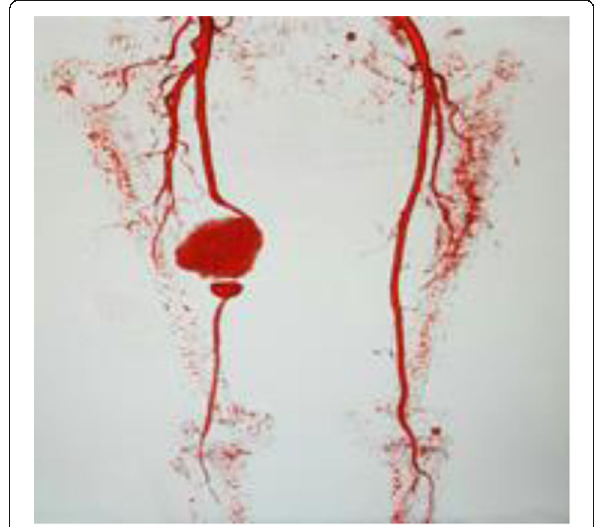
Fig. 1 (abstract P191). Aneurisma de Artéria